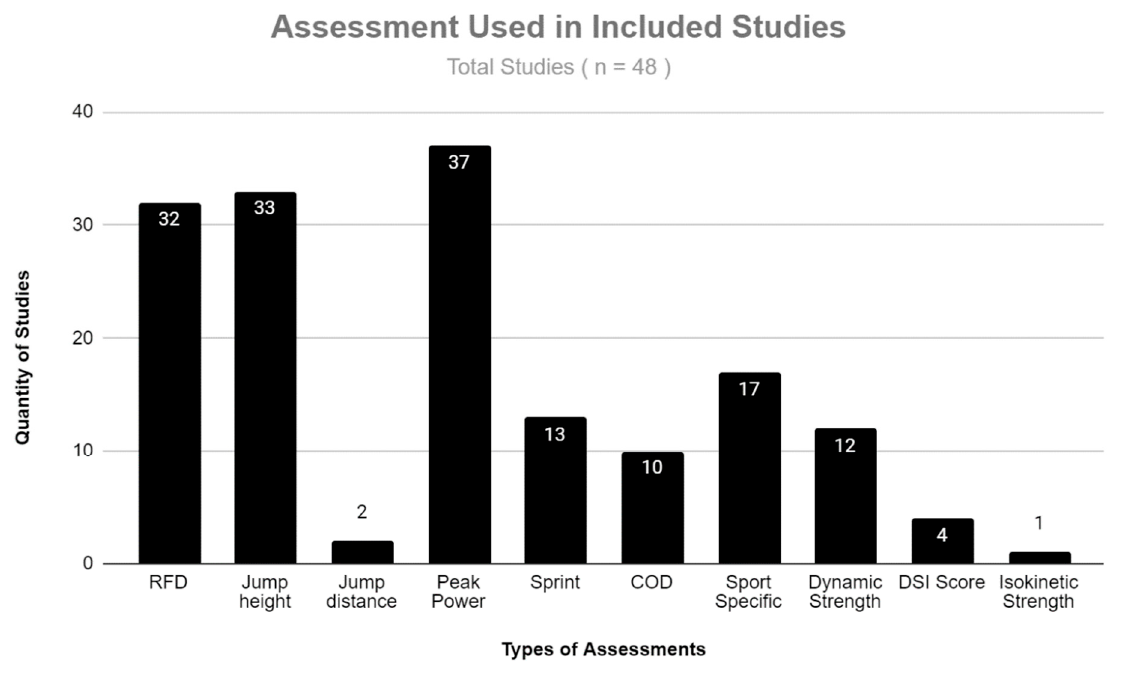
Figure 2. Distribution of types of assessments used in included studies.